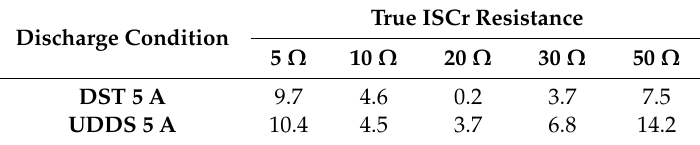
Table 4. Relative error (%) of the final value of R ISCf depending on the ISCr faults in the simulation model.